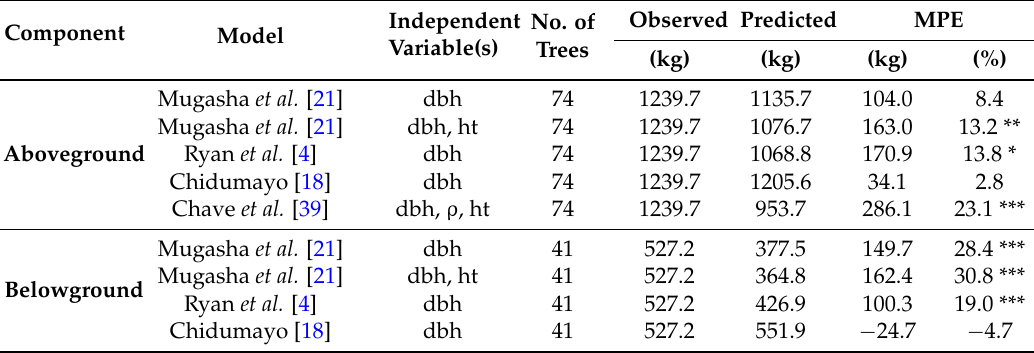
Table 8. Mean prediction error (MPE) of previously developed